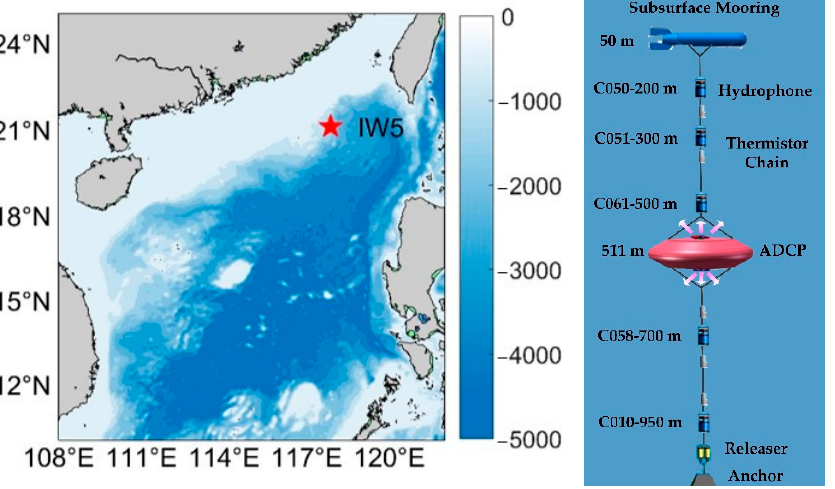
Figure 1. The topography in the South China Sea. The red pentagram indicates the location of the experimental site (IW5 station). The right figure shows the subsurface mooring system.